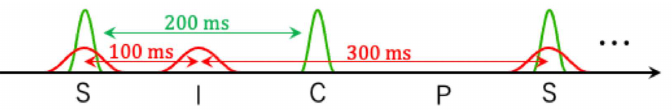
Figure 6 . Four beam combinations with the two laser pulses. The green and red pulses are creation and inducing laser pulses, and the repetition rates are 5 Hz at equal and irregular intervals, respectively. We denote four pulse combinations: S for both laser pulses, C for only the creation laser pulses, I for only the inducing laser pulses, and P for a pedestal measure without laser